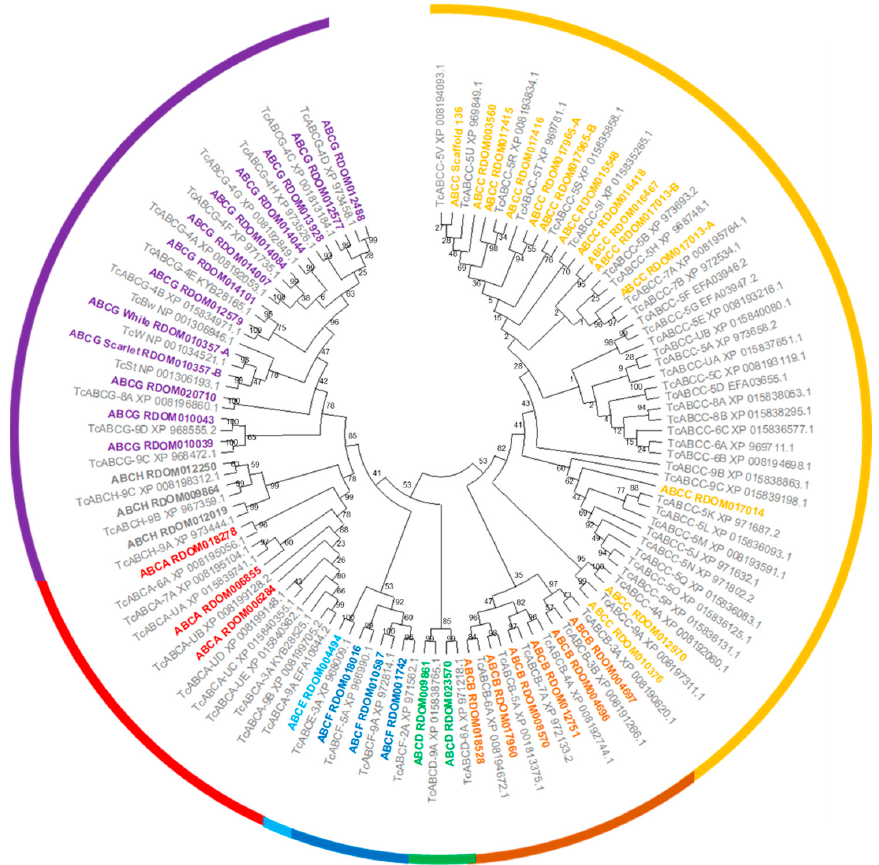
Figure 2. Phylogenetic tree of ABC transporters from R. dominica and T. castaneum . ABC transporters from R. dominica were named by combining the subfamily name with the name of the corresponding gene model. ABC transporters from T. castaneum were taken from previous studies [61] with the accession number provided for reference. The bootstrap values (%) are given at the nodes. ABC subfamilies (A–H) are indicated by different colors.